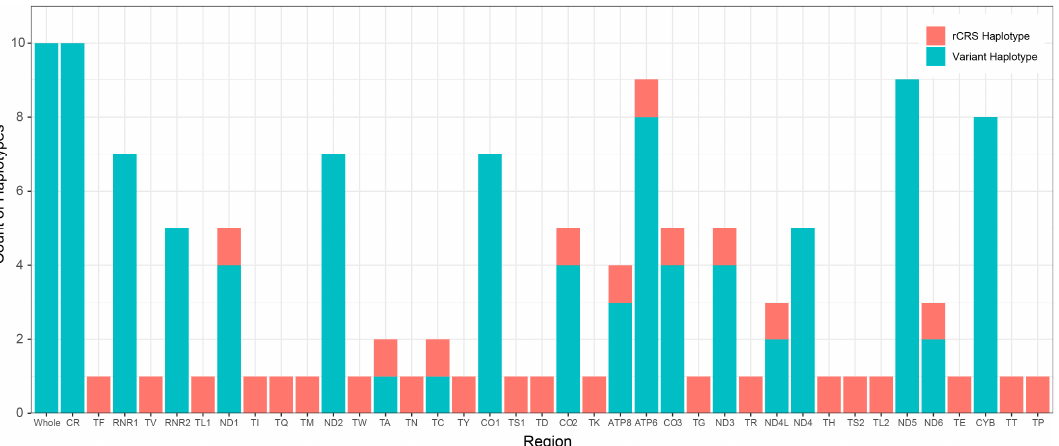
Figure 6. Count of haplotype types observed in the whole mtGenome, control region, and coding region.